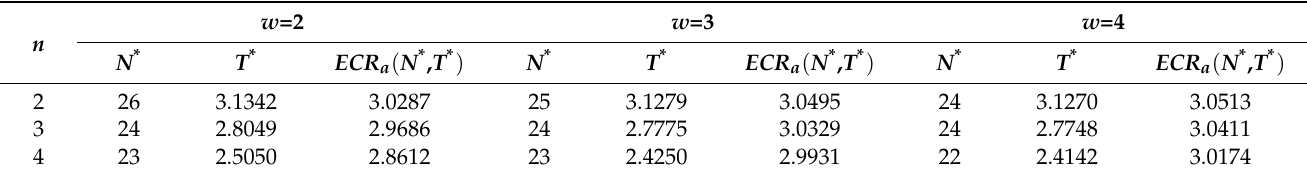
Table 1. The impact of the former stage warranty on the optimal RNN.